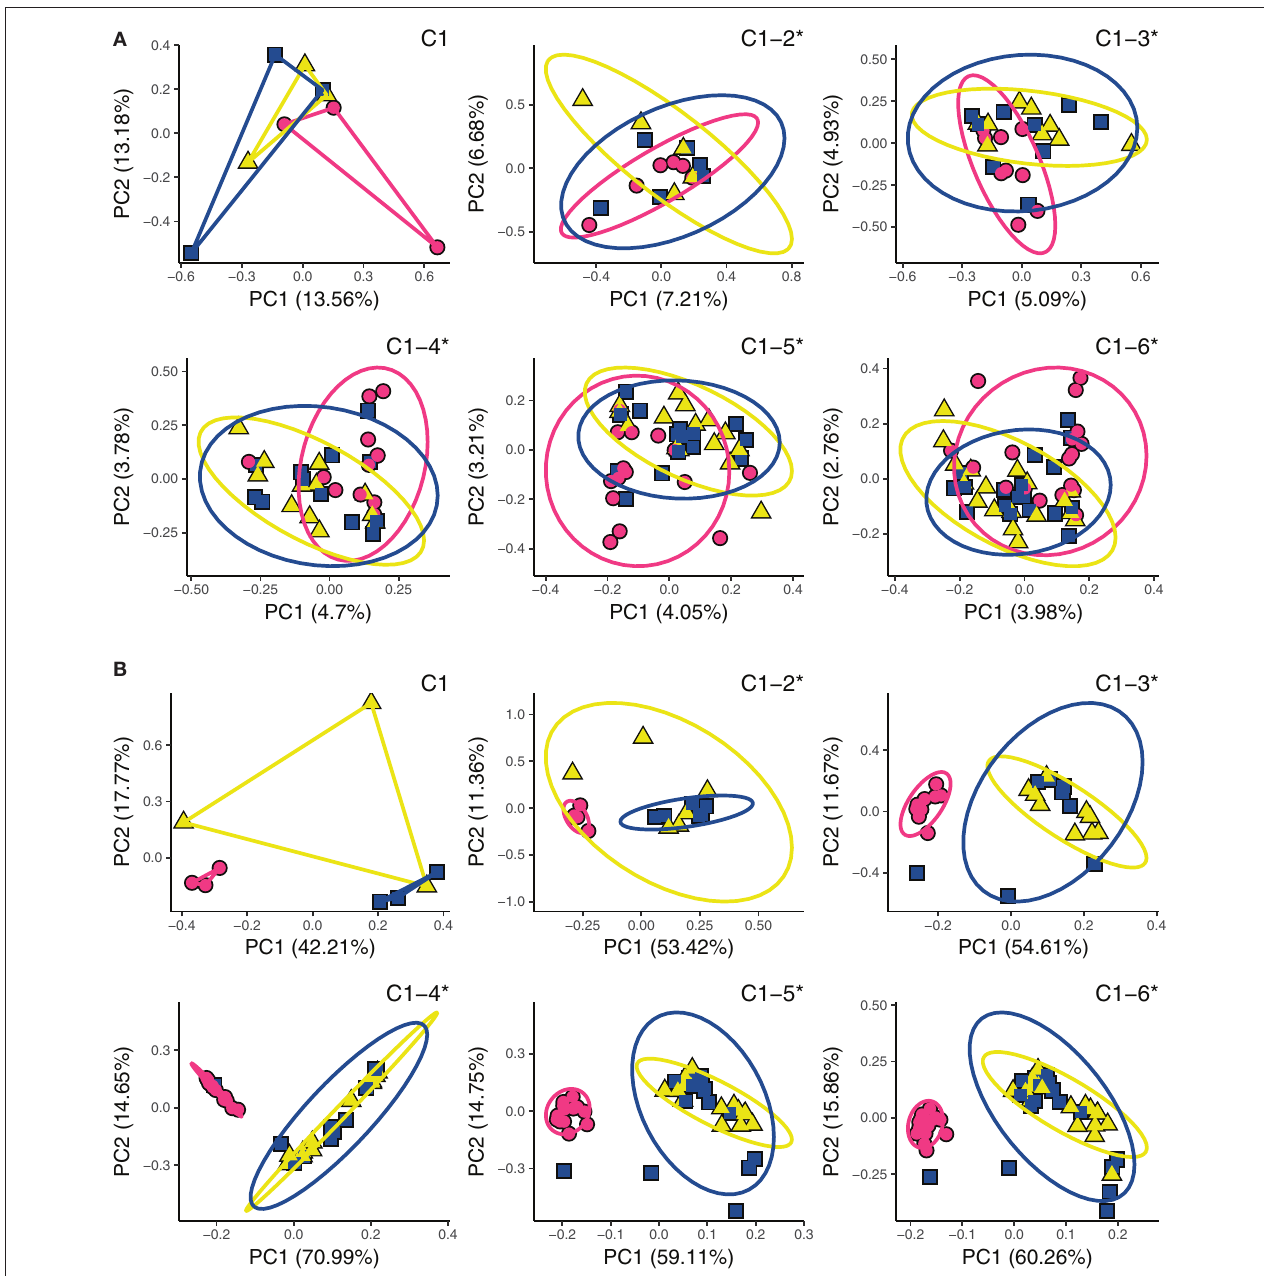
FIGURE 3 | Principal component analysis (PCA) ordination showing (A) prokaryotic and (B) fungal community similarity. Each panel shows an accumulation of samples, starting with crop cycle 1 (C1) and ending at cycle 6 (C1-6). Asterisks (*) denote PERMANOVA significant treatment differences across crop cycles.